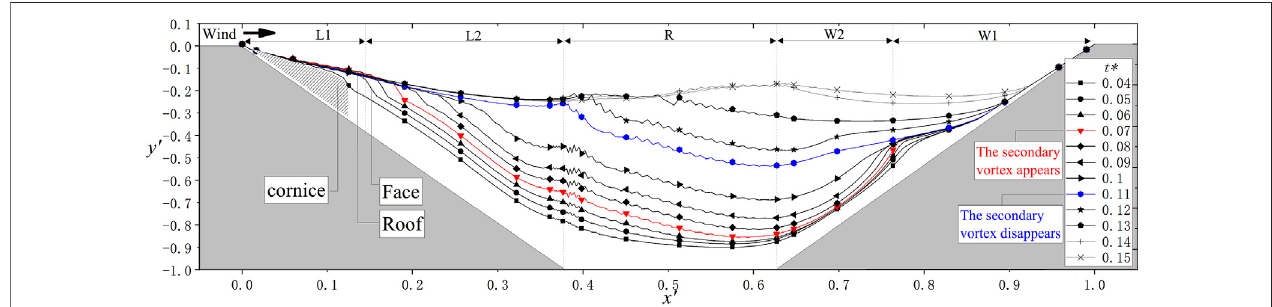
FIGURE 12 | Simulated snow distribution. In Figure 11 , the results of the snow evolution process in road cutting are presented. Snow cornice is formed on the leeward side slope. Its face and roof have certain characteristics. The cornice roof remained balanced between erosion and deposition, creating a new leeward-side slope with a slope ratio of 1:4. Moreover, the position of its face is related to the formation of the secondary vortex.